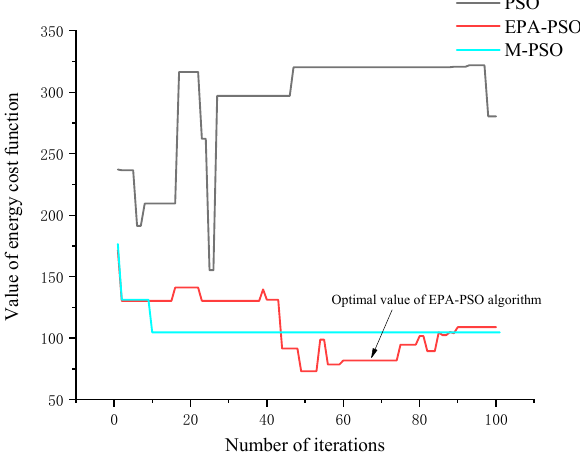
Figure 12. The weight of cost function of EPA-PSO algorithm after 500 iterations.